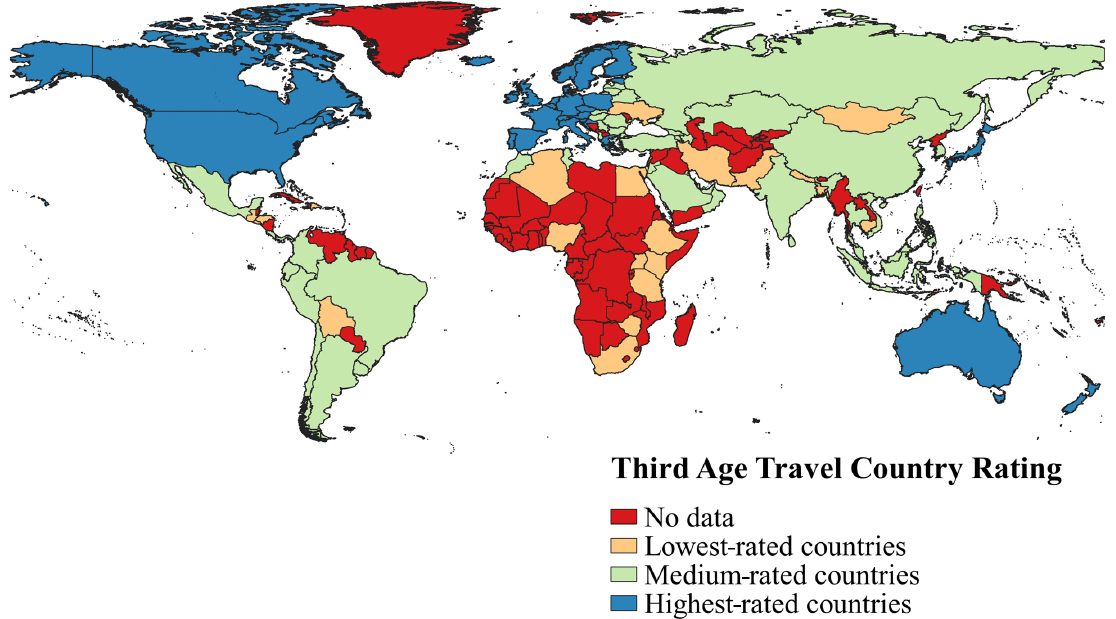
Fig. 2. The position of the world countries according to the rankings for travel of people of the third age. Source: based on: Home – Third Age